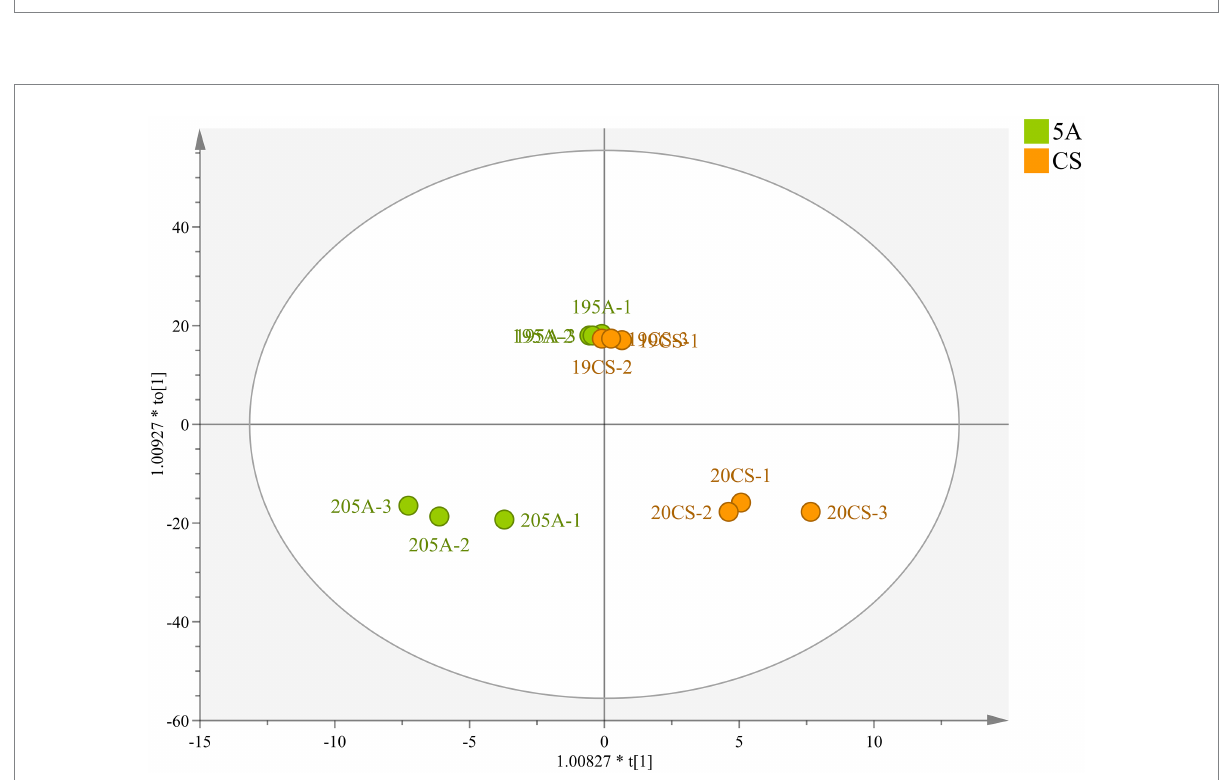
FIGURE 3 OPLS-DA based on flavonoid compound concentrations in wine of CS and CS/5A in the 2019 and 2020 growing